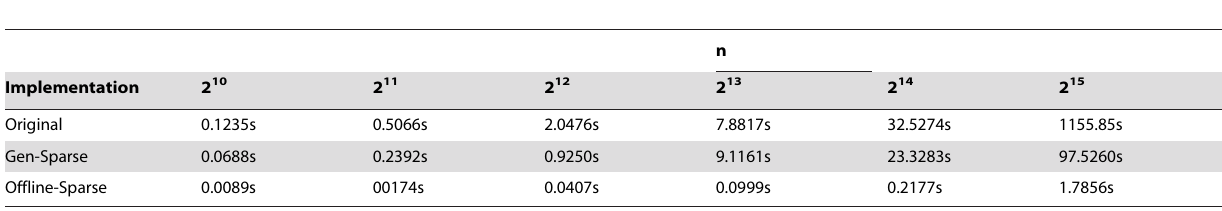
Table 1. Processing time (in seconds) for denoising a single spectrum using different implementations of the modified Antoniadis- Sapatinas algorithm.